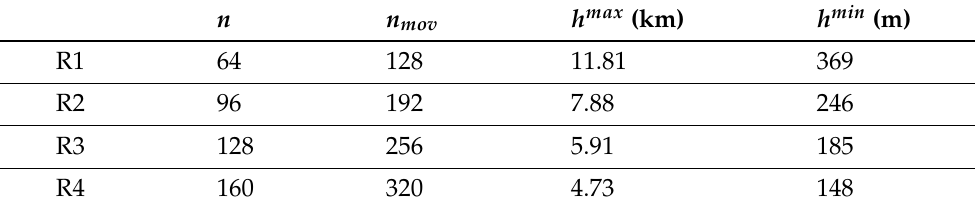
Table 3. Table of resolutions with columns showing the number of points per direction of the fixed levels and of the moving levels, the grid spacing of the coarsest level and the grid spacing of the finest one respectively. For all binary neutron star configurations we used 6 refinement